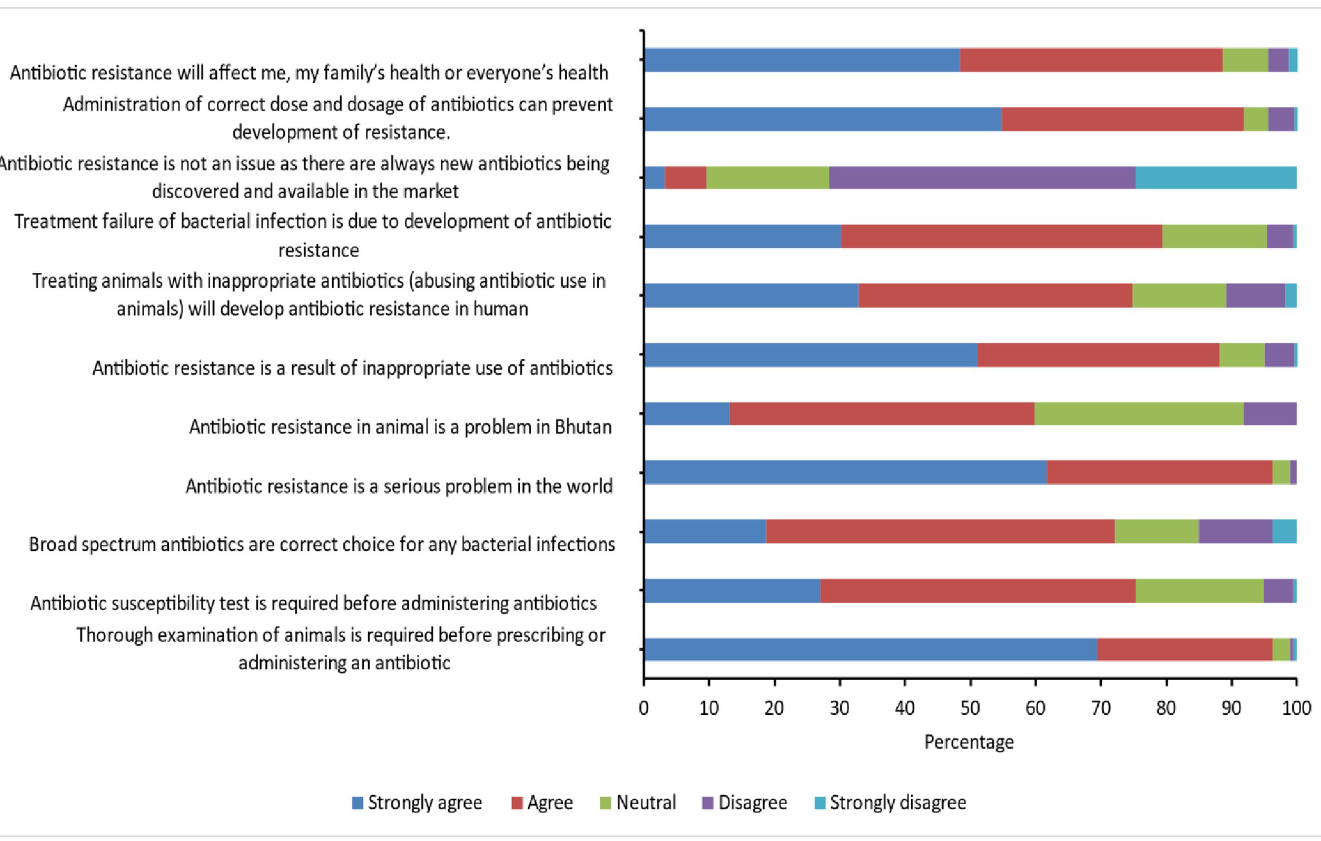
Fig 3. Attitude on antibiotic usage and AMR among the 219 respondents (animal health workers in Bhutan).